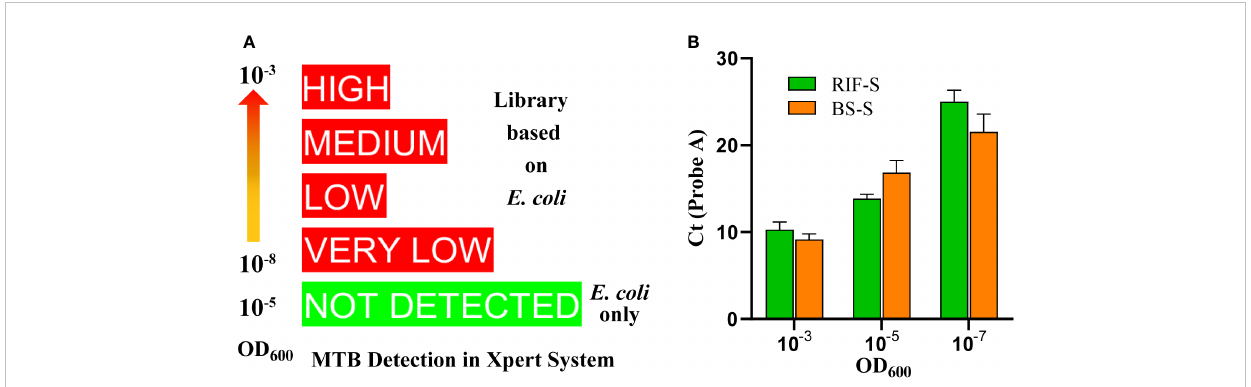
FIGURE 2 Quantitative and semi-quantitative results according to optical density values at 600 nm (OD 600 ). (A) Semi-quantitative readings from the library based on ( E ) coli in the Xpert MTB/RIF assay, showing that OD 600 of specimens ranges from 10 -8 to 10 -3 . The rank is associated with the mutants and lots. (B) Cycle threshold (Ct) values of probe A for ( E ) coli and ( B ) subtilis with the same OD 600